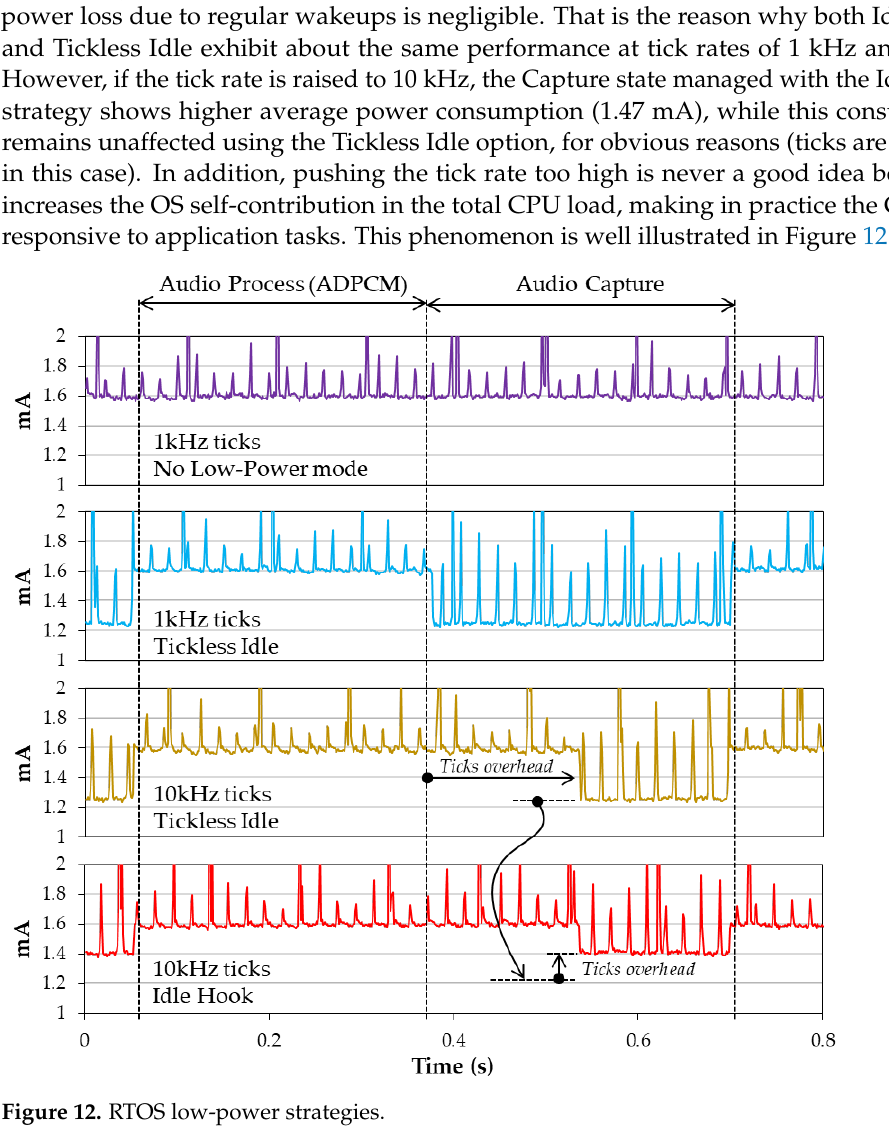
Table 4. Average supply current (mA) measured during Capture and Process states for various tick rates and low-power idle strategies.